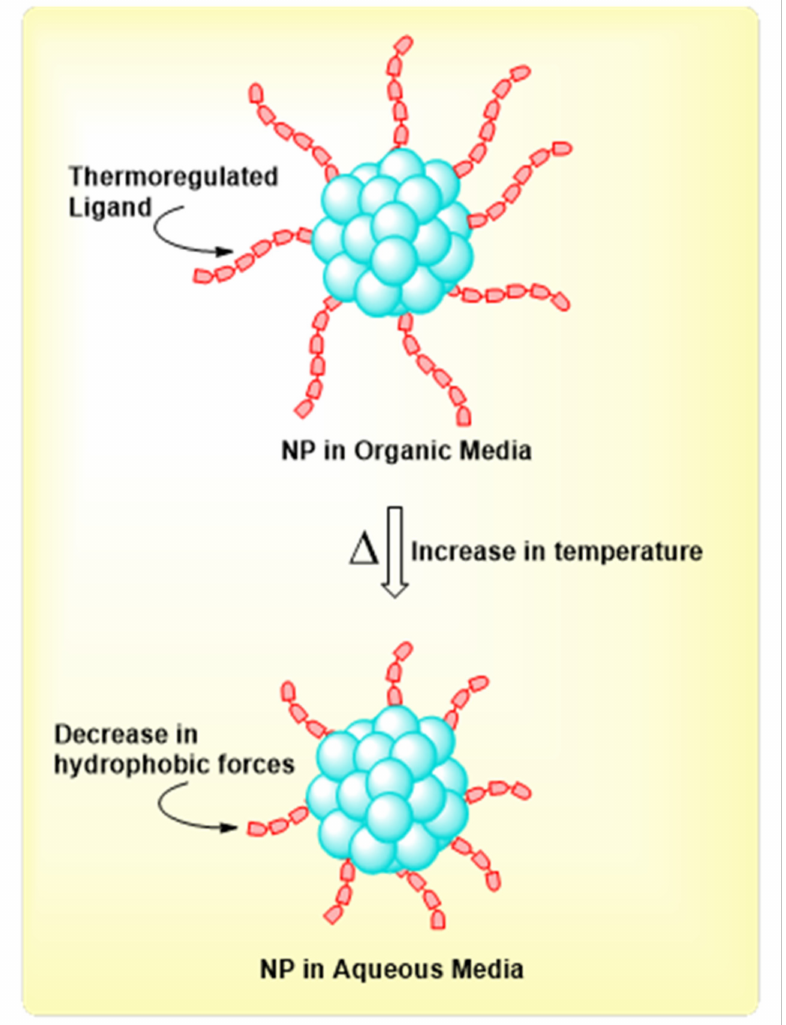
Figure 9. Schematic representation of phase transfer via thermoregulation. In the figure, the abbrevi- ation “NP” means